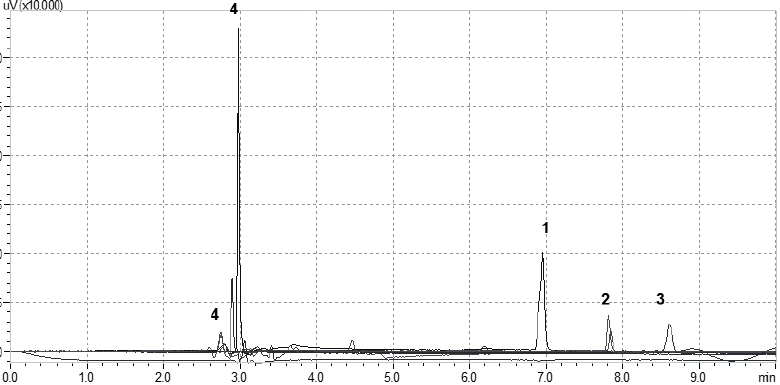
Figure 2. Selectivity of the HPLC-TBARS-EVSC assay. Chromatogram of 1: TBARS reaction (adduct); 2: sunscreen system and adhesive tape (irradiated and non-irradiated); 3: n-butanol; and 4: 0.2% BHT, H 3 PO 4 0.44 M and 1% H 2 SO 4 . Retention time (min).